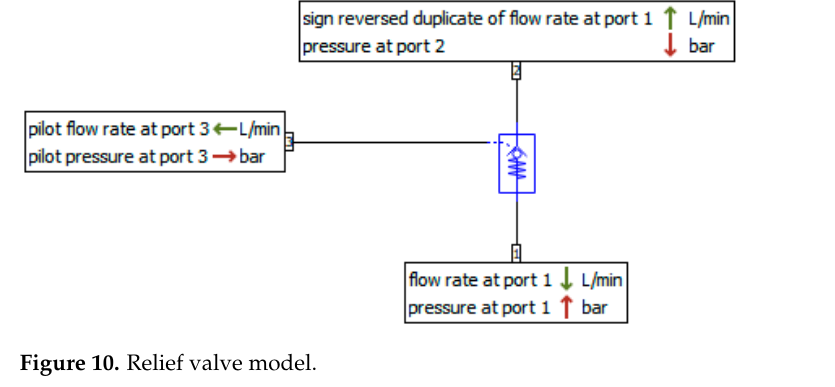
Figure 10. Relief valve model.